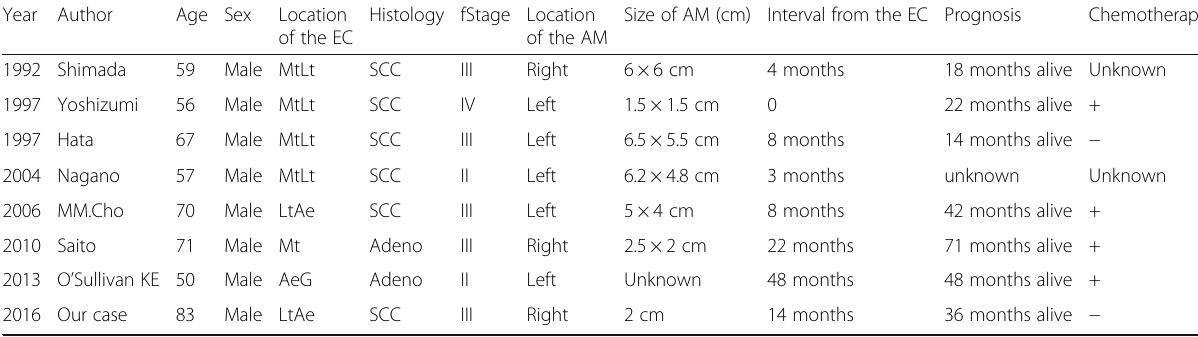
Table 1 Eight patients with surgical resection of adrenal metastasis from esophageal carcinoma Year